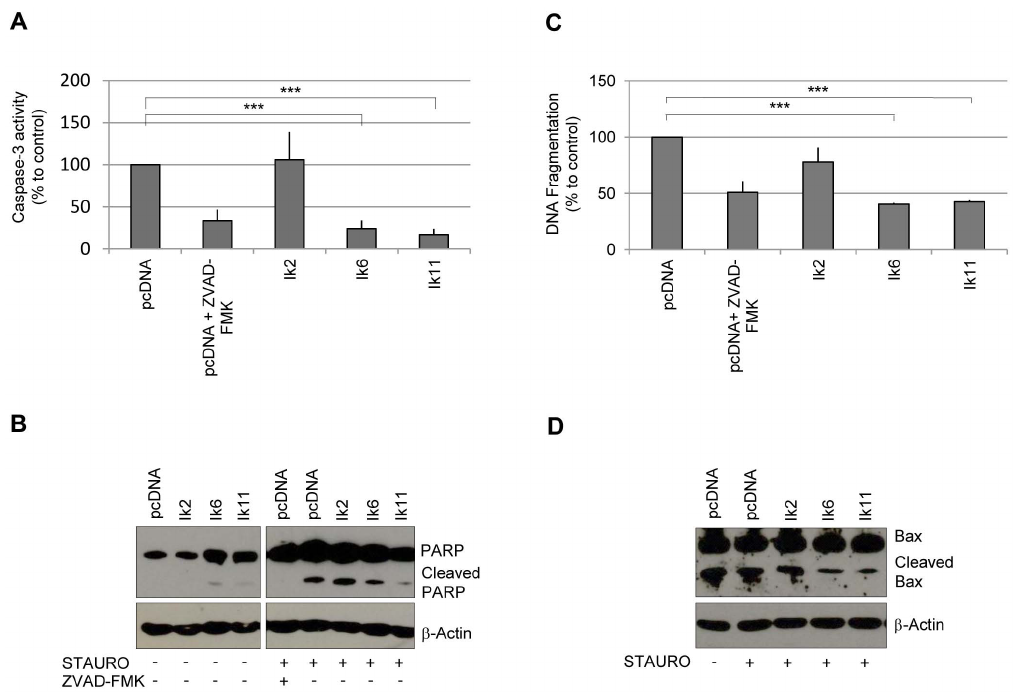
Figure 6. Ik11 overexpression protects against apoptosis. Evaluation of apoptosis by measurement of caspase-3 activity ( A ), examination of PARP cleavage products ( B ) and determination of mono- and oligo-nucleosome enrichment ( C ). Raw 264 cells were transfected with pcDNA3.1-Ik2, pcDNA3.1-Ik6, pcDNA3.1-Ik11 or empty vector and were incubated with 100 nM staurosporine or vehicle for 14 hours. Empty vector-transfected cells were also treated with 50 m M Z-VAD-FMK, a general caspase inhibitor. Values were calculated as percent of control (pcDNA3.1). Mean 6 SD is shown (*** p , 0.0001) (A,C). Data shown are representative of three different experiments. ( D ) Western blot analysis of Bax protein. Raw 264 cells were transfected with Ikaros isoforms and treated with staurosporine as previously described. Protein levels of Bax and Bax/p18 cleavage products are shown.